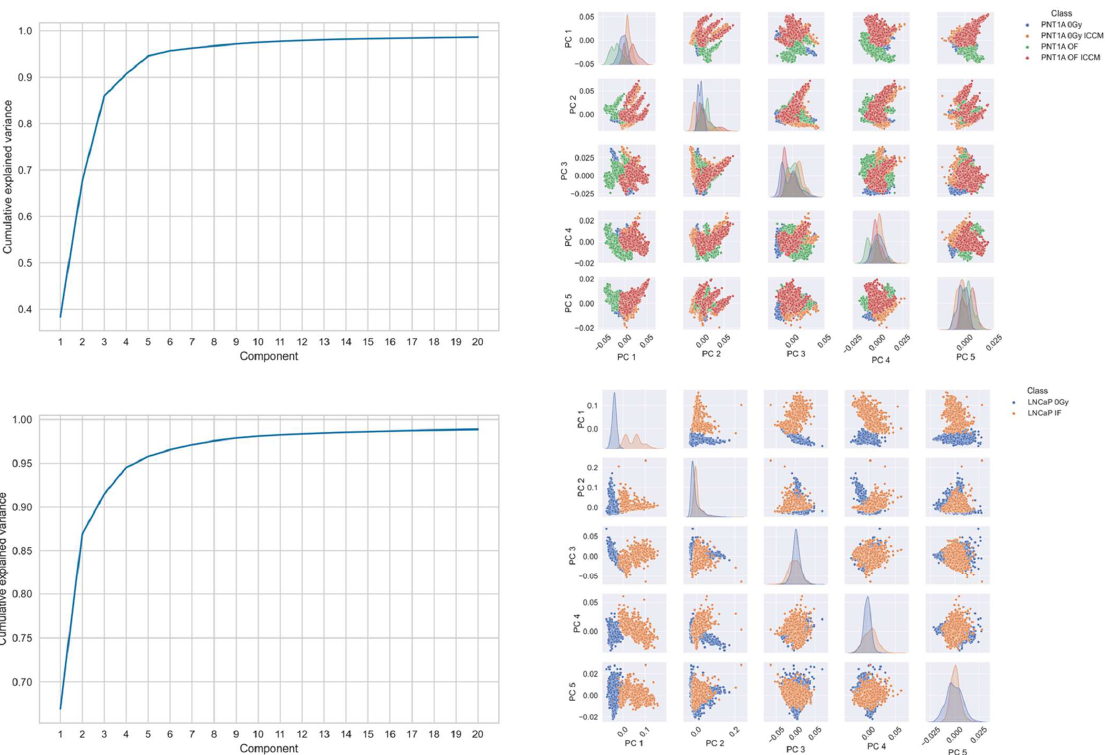
Figure 2. Principal components analysis of ( top panel) PNT1A cell line and ( bottom panel) LNCaP cell line spectra. In each panel the left figure displays the cumulative explained variance and the right displays a pairs plot of the principal component scores for the first 5 principal components.